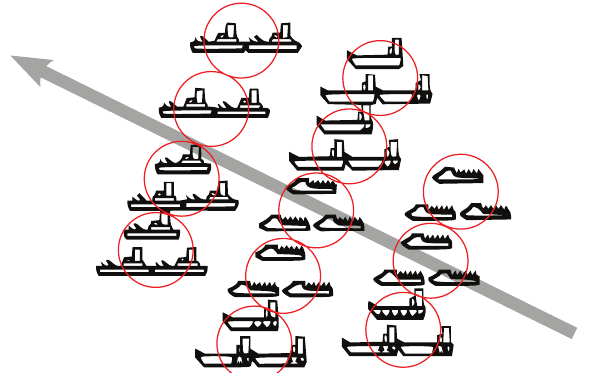
Figure 6: Fleet formation in DEFCON with front direction shown. Each circle indicates a separate fleet of up to three ships.